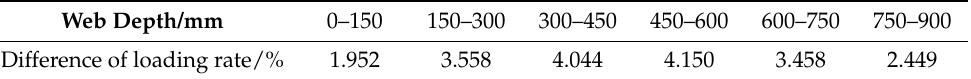
Figure 23. Loading rate of particles with different web depths.